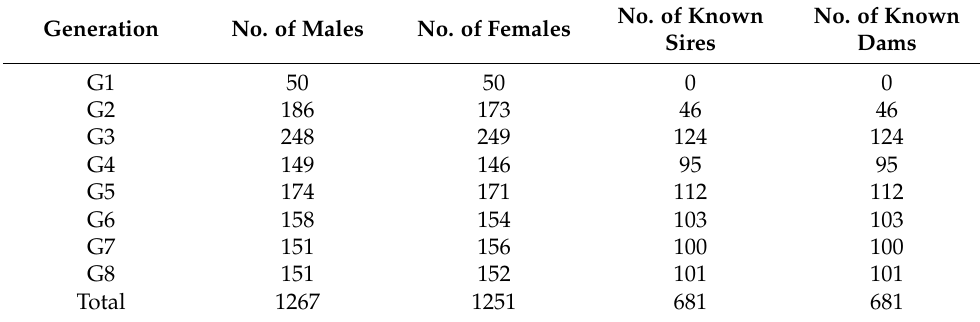
Table 2. Numbers of male and female mice in pedigree data from Ogawa and Satoh [57]. Generation No. of Males No. of Females